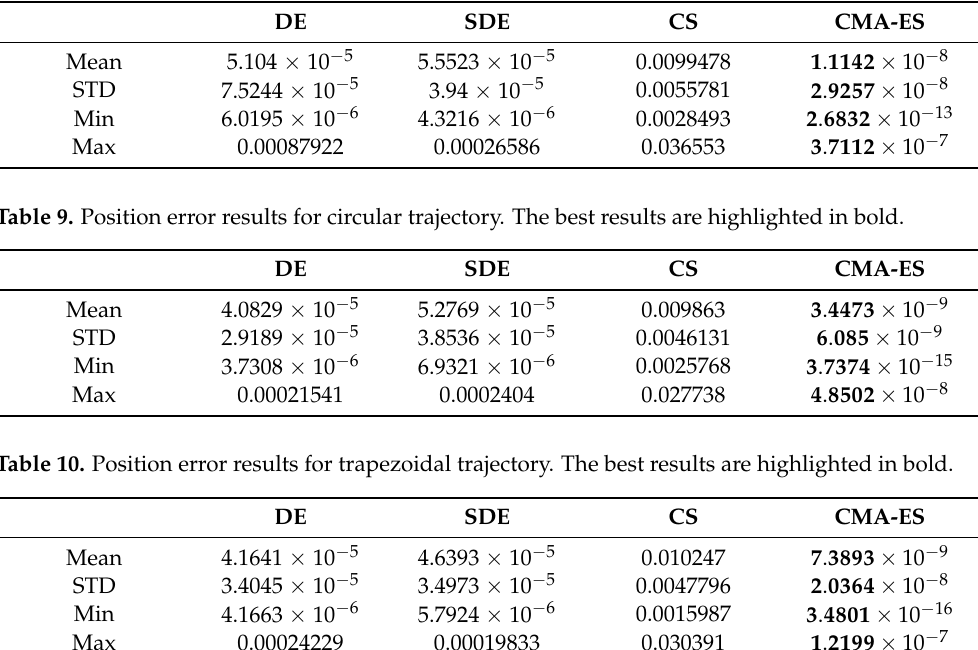
Figure 7. Position error results of coordinated trajectory tracking tests. Table 8. Position error results for sinusoidal trajectory. The best results are highlighted in bold.